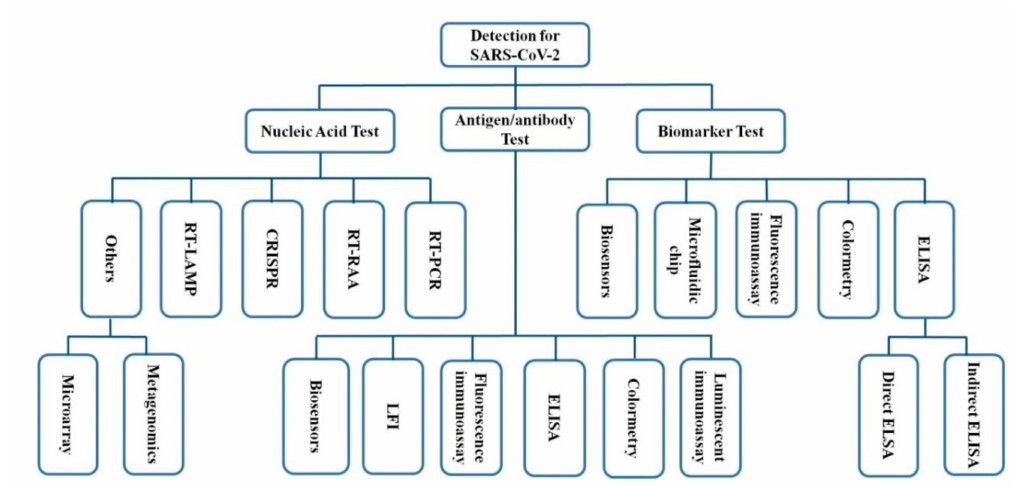
Figure 8. A summary of various methods that can be applied in SARS-CoV-2 detection (ELISA: enzyme-linked immunosor- bent assay; LFI: lateral flow immunoassay [46,70–76,79–86]). Table 1. Comparison of performance of different detection methods for